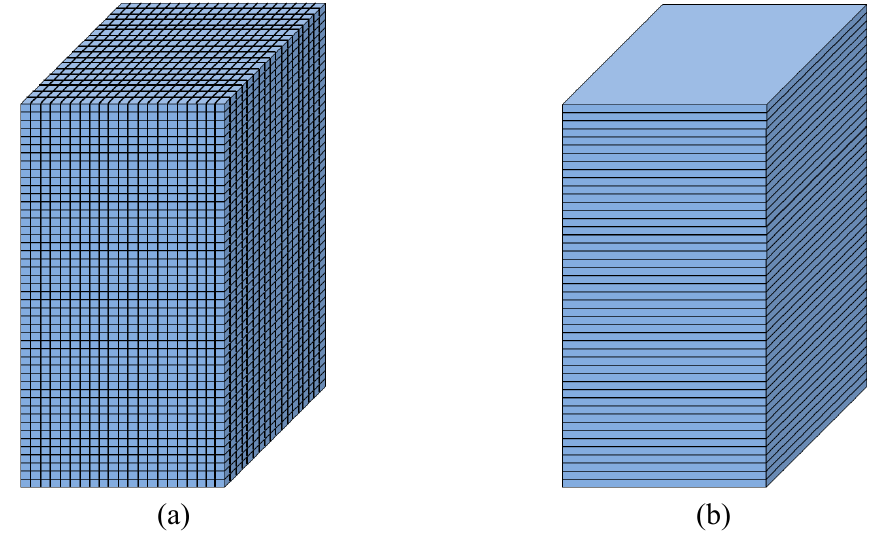
Figure 28. Different training approaches for ANN at ( a ) Cell Level ( b ) Layer Level. Figure 28. Di ff erent training approaches for ANN at ( a ) Cell Level ( b ) Layer